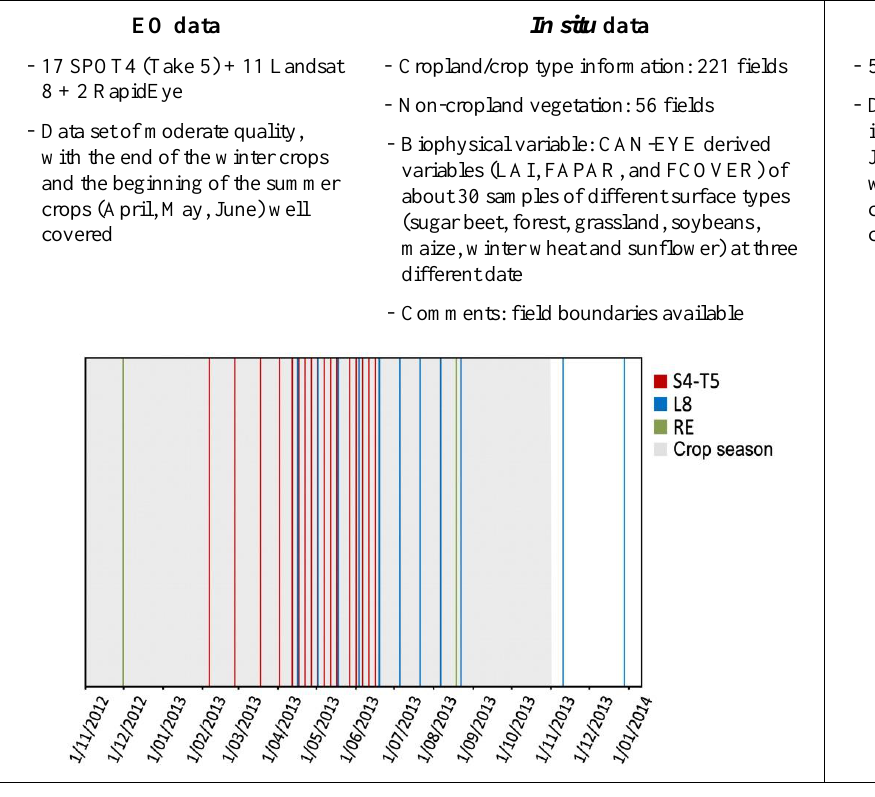
Figure 8. Description of the TDS acquired over each site.